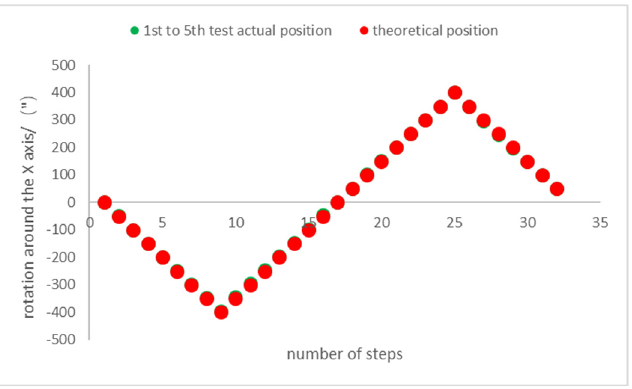
Figure 16. Attitude accuracy measurements for deflection around the x-direction.